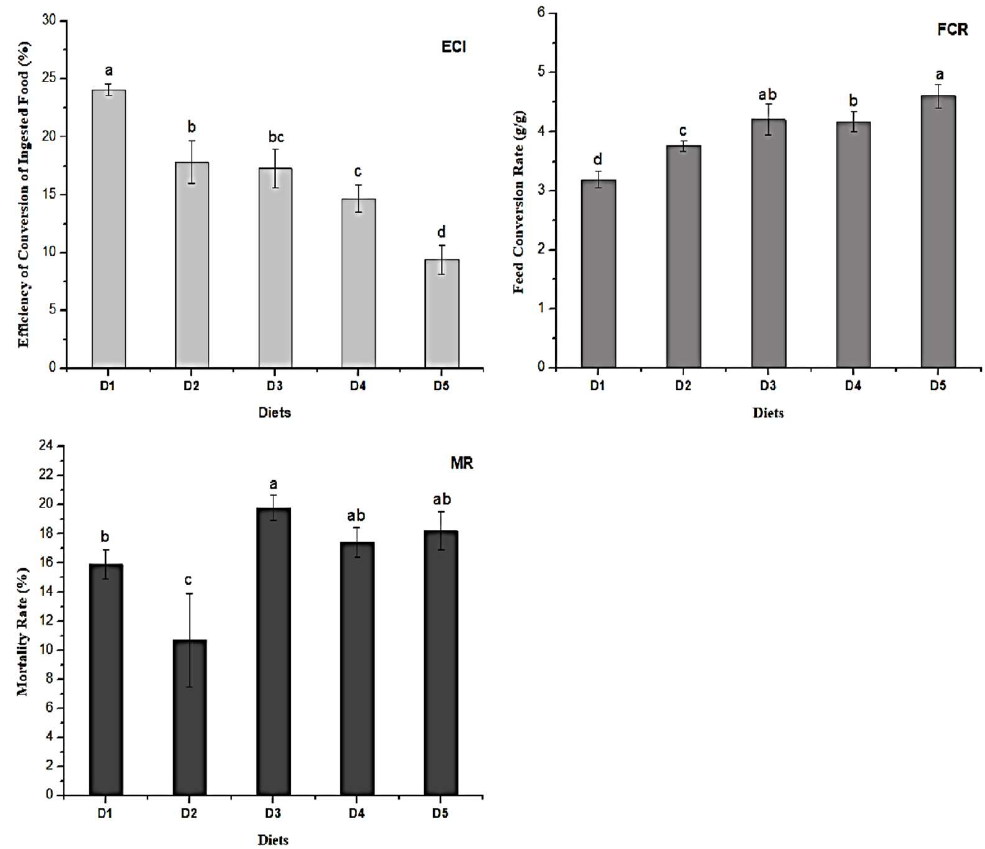
Figure 2. Efficiency of Conversion of Ingested food (ECI), Feed conversion rate (FCR), and Mortality rate (MR) of Zophobas atratus larvae fed a conventional diet with or without grape residue for 90 days. Diets: D1 = 100% 70 g/100 g poultry feed and 30 g/100 g ground maize mixture (control); D2 = 75% D1 + 25% D5; D3 = 50% D1 + 50% D5; D4 = 25% D1 + 75% D5; D5 = 100% grape juice production residue. Different letters indicate significant differences by Tukey’s test ( p ≤ 0.05; n = 3).